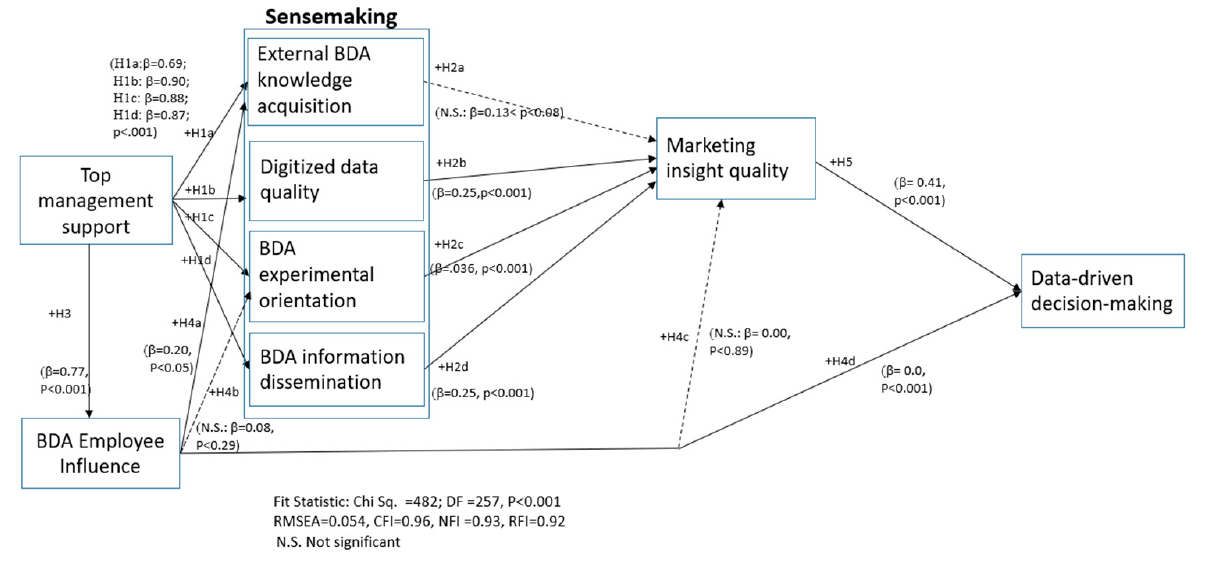
Figure 2. Results: Marketing BDA Sensemaking and Data Driven Marketing